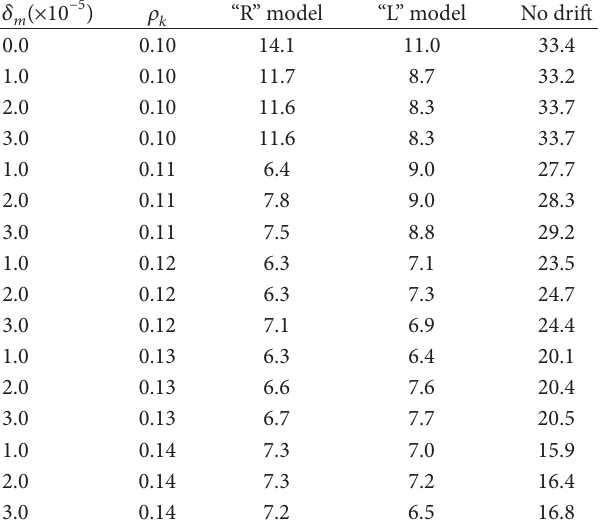
(in percentage, T 6: Average values (last three columns) of rms ) as a function of ( ) and , for BESS-1997, AMS-1998, PAMELA-2006/08, obtained from (17) without enhancement of the 𝜂𝜂 −5 ), using “R” diffusion tensor along the polar direction ( % 𝛿𝛿 𝑚𝑚 ×10 𝜌𝜌 𝑘𝑘 and “L” models for the tilt angle and No Dri approximation. e differential intensities were calculated accounting for particles 𝜌𝜌 𝐸𝐸 = 1 inside the heliospheric regions for which solar latitudes are lower . than ∘ “R” model “L” model No | |5.7 −5 𝛿𝛿 𝑚𝑚 (×10 ) 𝜌𝜌 𝑘𝑘